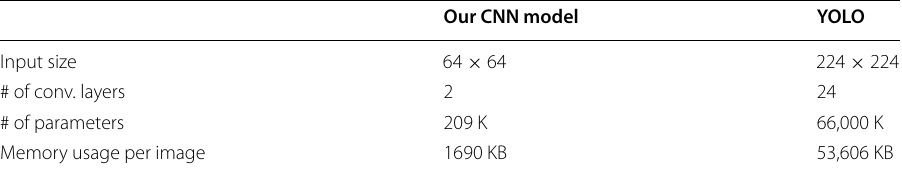
Table 5 Complexity and memory usage of our approach and a state-of-the-art object detection method (YOLO) Our CNN model YOLO Input size 64 × 64 224 × 224 # of conv. layers 2 24 # of parameters 209 K 66,000 K Memory usage per image 1690 KB 53,606